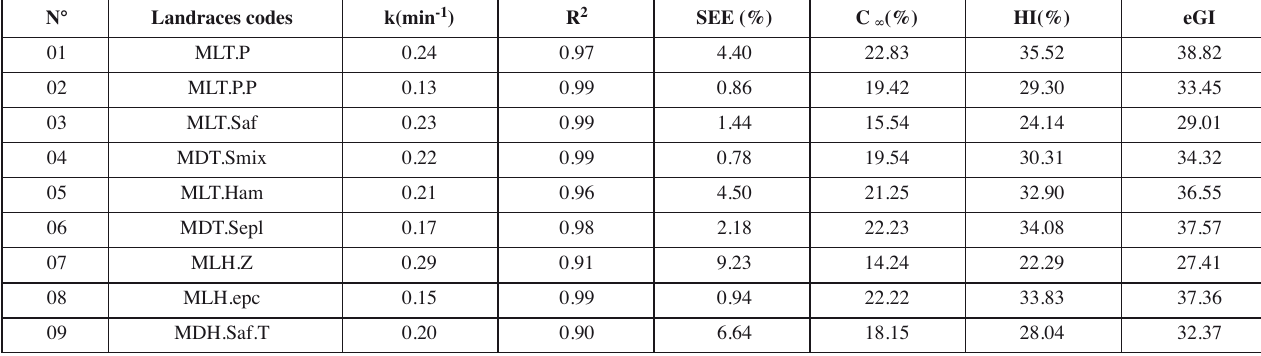
Tab. 3: Starch digestibility and expected glycemic index parameters of the first-order model for the pearl millet flours a . N°